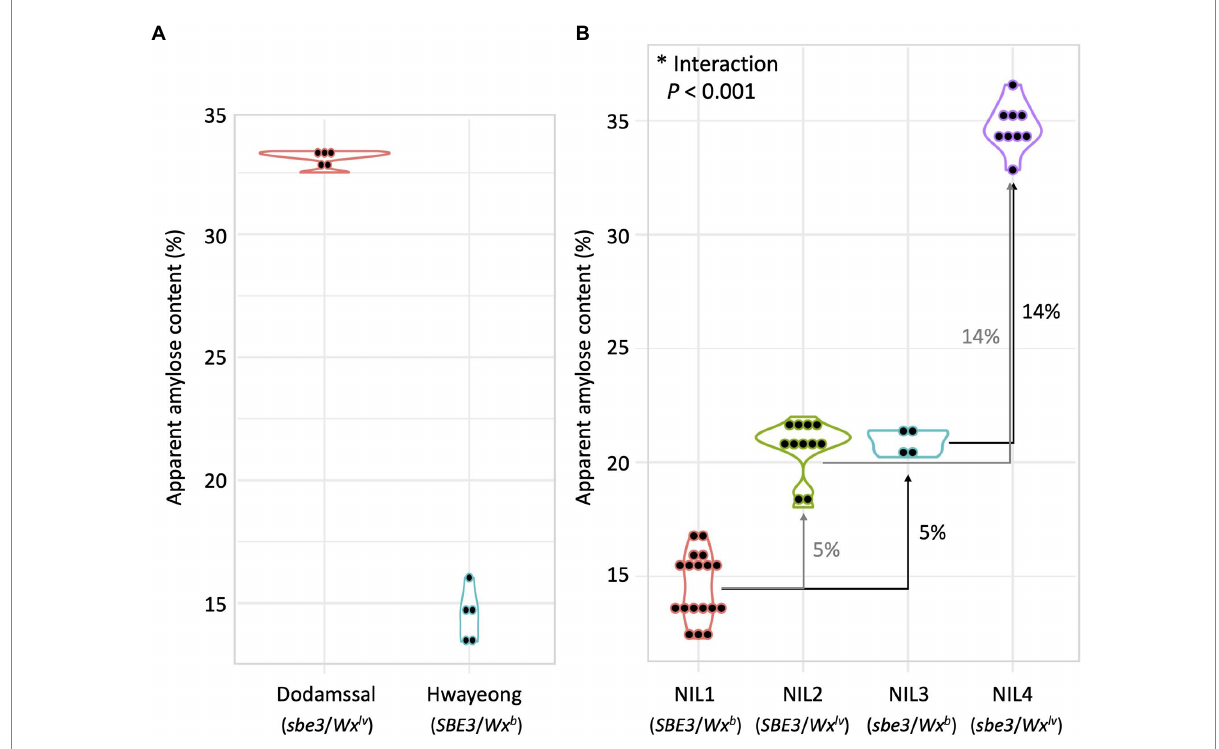
FIGURE 4 Comparison of apparent amylose content (AAC) between (A) Dodamssal and Hwayeong, (B) four NILs. Violin plots were used to show distribution of data points. The numbers beside the arrows indicate increased